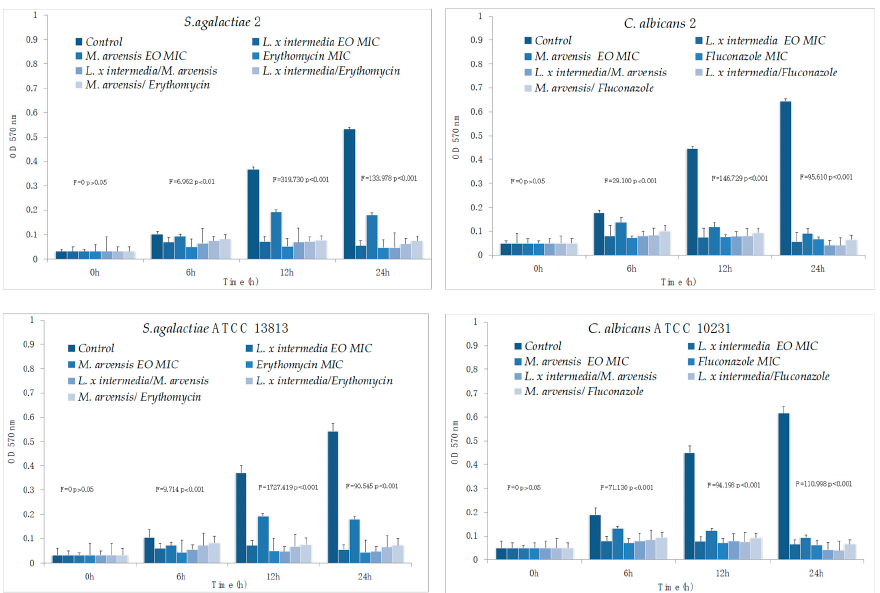
Figure 1. Time–kill studies of L. x intermedia , M. arvensis EOs, antimicrobials (erythromycin and fluconazole) and of different combinations (antimicrobial/EO and EO/EO) against Streptococcus agalactiae and Candida albicans strains. p ‐ values of < 0.05, p < 0.01, p < 0.001 and p < 0.0001 were considered significant by t ‐ test and ANOVA.